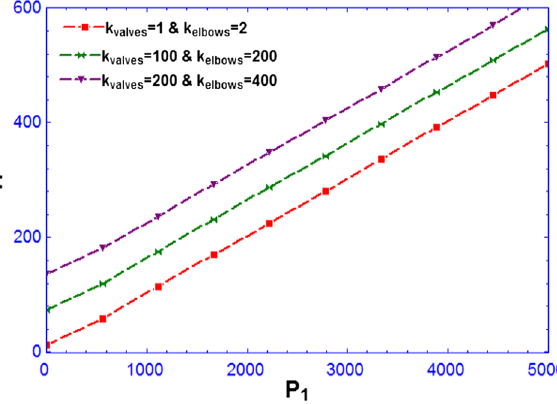
Fig. 16 Total head of pump versus pressure through the